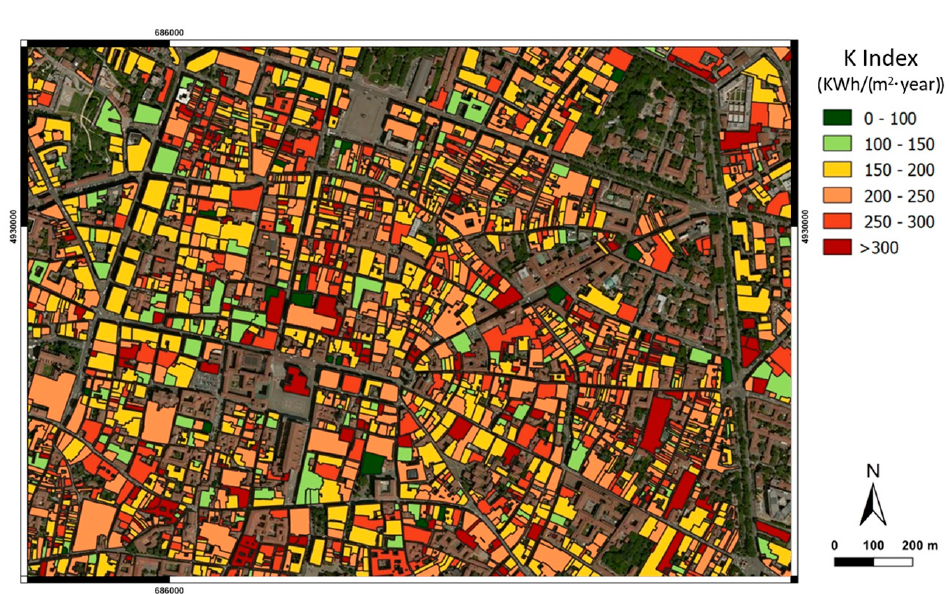
Table 2. Summary of resulting data. Figure 3. K index map at cadastral parcel scale. Bing aerial imagery is used as the base map.